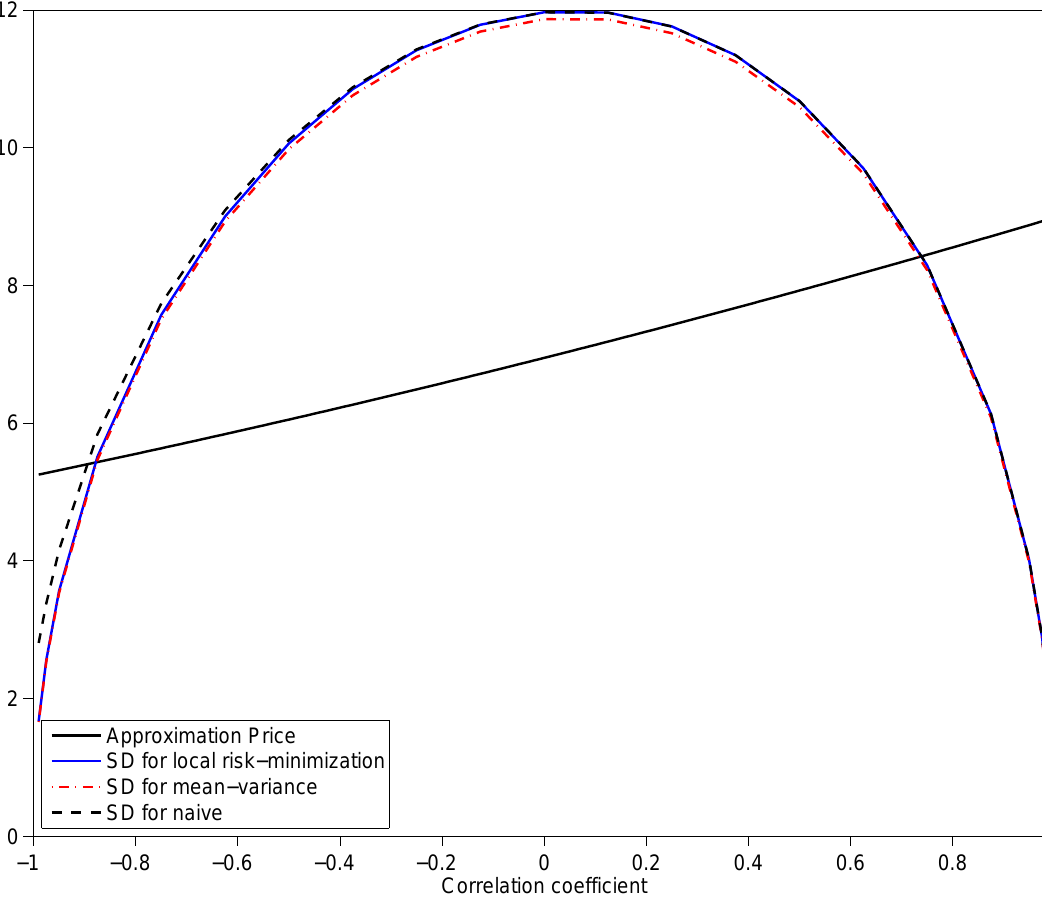
Figure 2. Approximation price and standard deviation of hedging error vs. correlation, for the put option with parameters given by Table